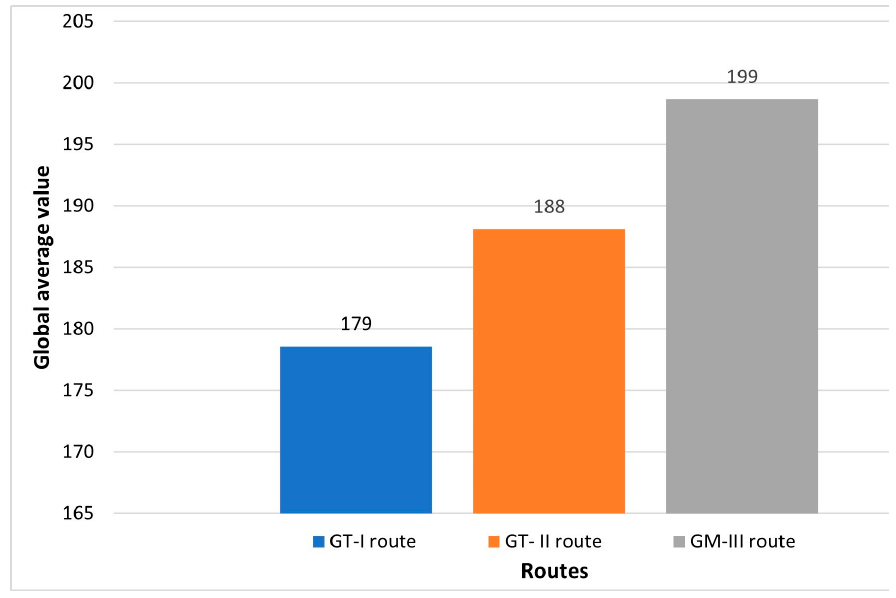
Figure 6. Global valuation (Gv) average of the geosites and mining sites that make up the routes studied.